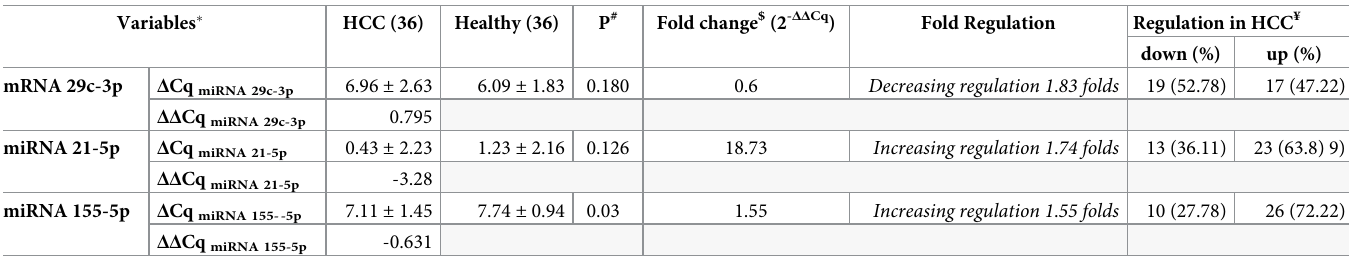
Table 1. The difference in Δ Cq, ΔΔ Cq and fold change of miRNA 29c-3p, miRNA 21-5p, miRNA 155-5p in HCC patients compared with healthy controls. Variables �